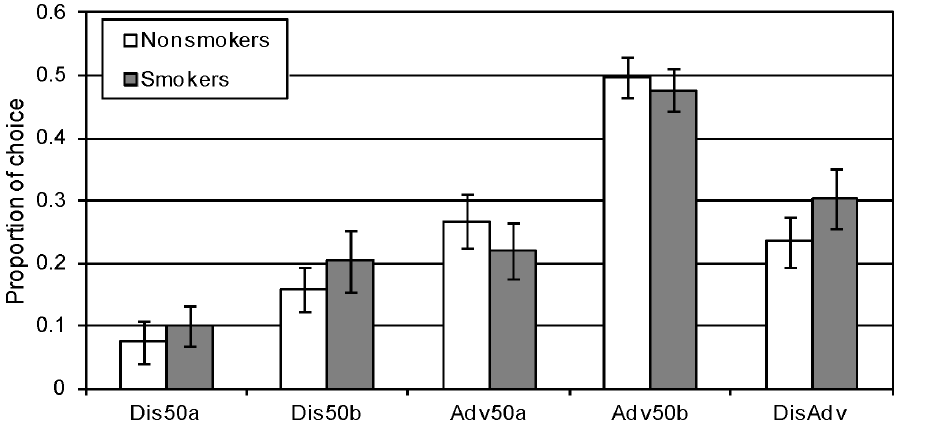
Figure 3. Smokers and nonsmokers choices from each of the decks of the EGT (average proportions and standard errors). The right column (Disadv) shows the proportion of choices from the disadvantageous decks (Dis50a + Dis50b).